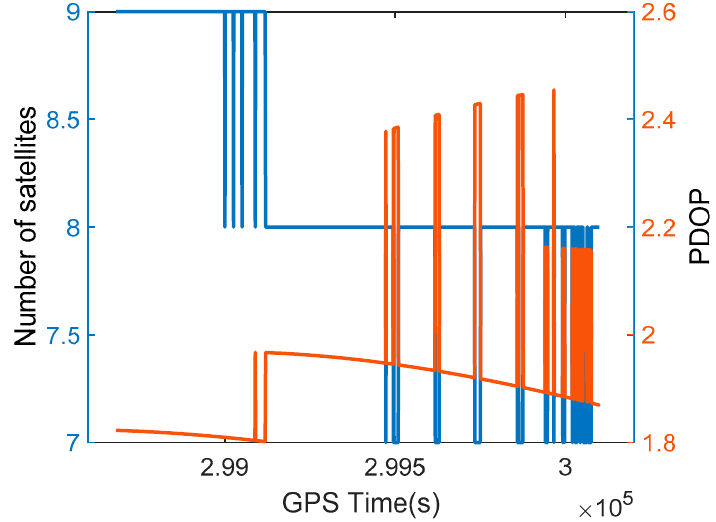
Table 1. The technical parameters of HG1700AG58.